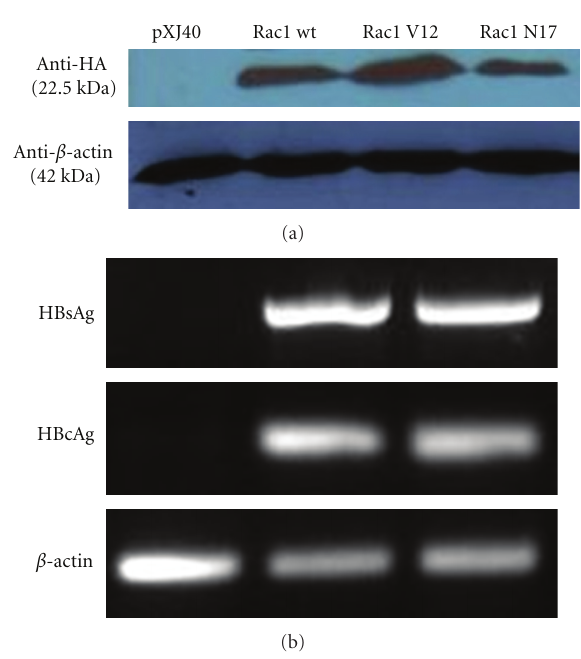
Figure 2: Western blot analysis, (a) expression of Rac1 wt, Rac1 G12V , and Rac1 T17N by western blotting. The internal control was β -actin, (b) RT-PCR on the expression of HBsAg and HBcAg of Wild- type HBV replicative genome and P-A mutant HBV genome. The negative controls was HepG2 cells transfected by empty vector pcDNA3.1. β -actin was the internal